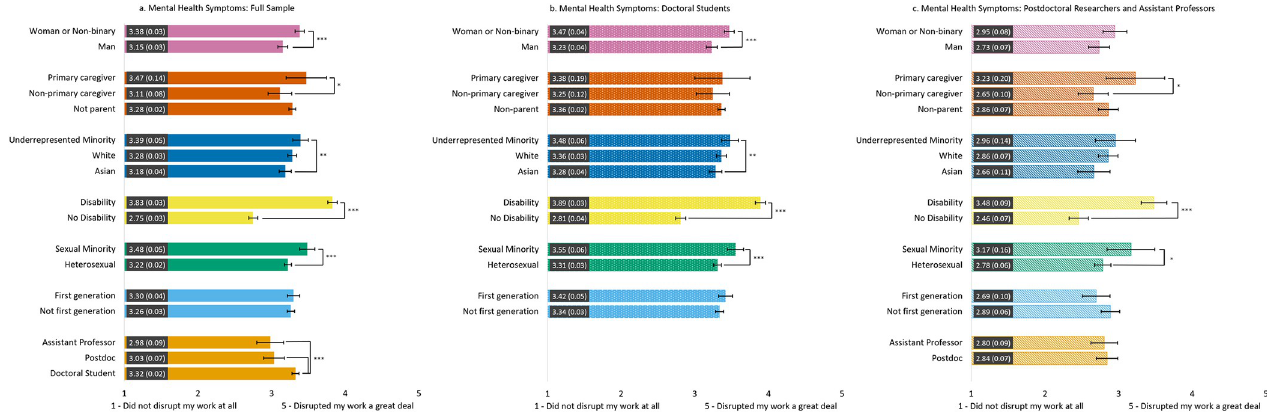
Fig 6. Estimated marginal means of disruptions to work due to mental health symptoms during the COVID-19 pandemic for the full sample (6a) and the doctoral student (6b) and postdoc/asst prof (6c) subsamples. Participants were asked to rate the degree to which mental health problems due to the COVID-19 pandemic disrupted their work with a Likert scale from 1 = Did not disrupt my work to 5 = Greatly disrupted my work . Error bars represent the 95% CI. Numeric values in each bar are the estimated marginal mean and standard error. � indicates p < .05, �� indicates p < .01, and ��� indicates p < .001. See S8 Table in S1 File for results of each model.